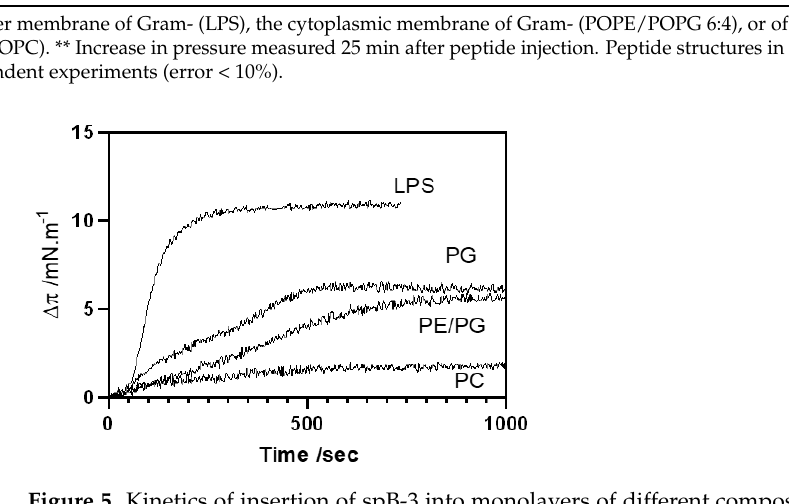
Figure 5. Kinetics of insertion of spB-3 into monolayers of different composition at constant area. Peptide concentration 0.48 µM. Initial surface pressure 32 mN.m − 1 .